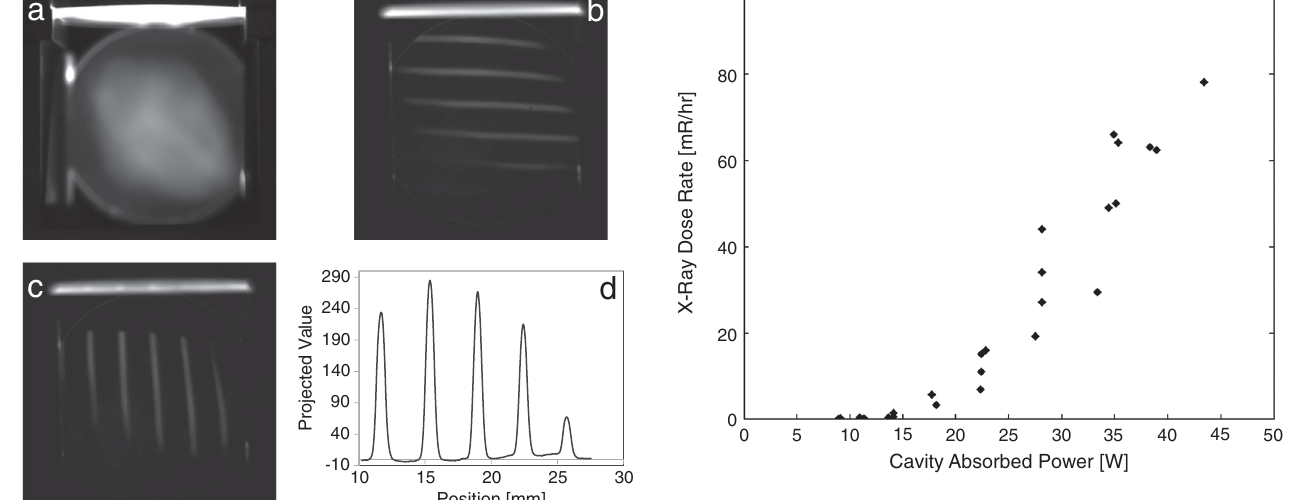
TABLE IV. Measured normalized rms emittance at 374 keV. Bunch